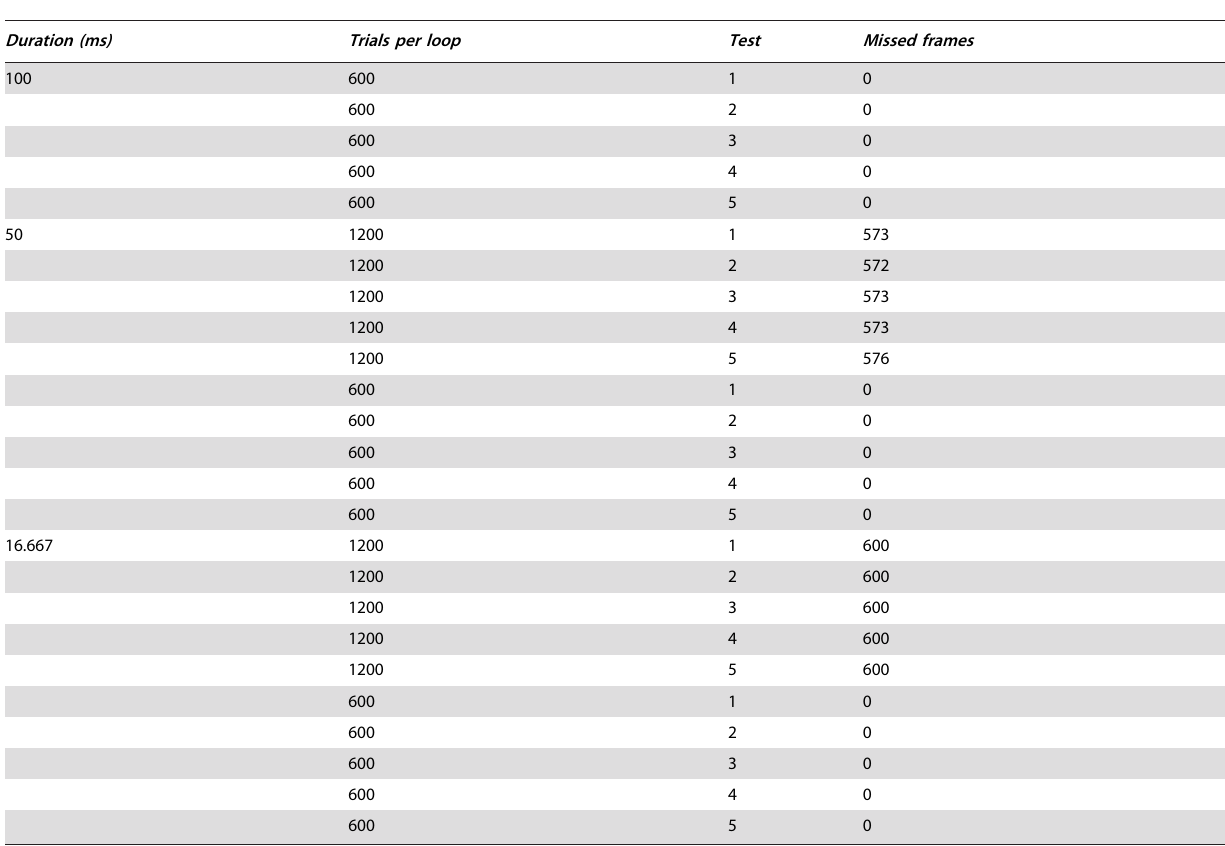
Table 4. PsychoPy 1.80 timing tests on MacBook Pro Mid 2009 under MacOS X